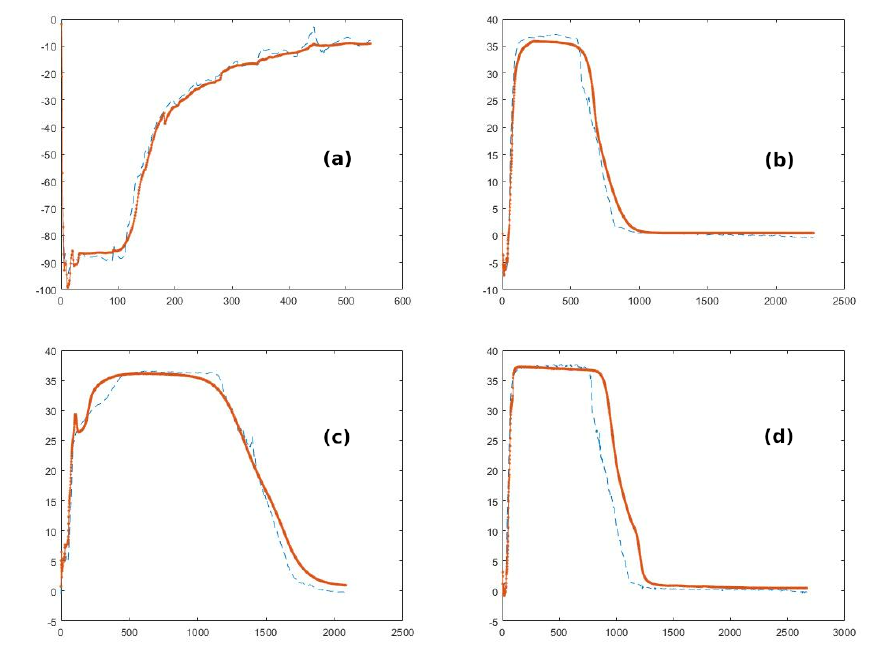
Figure 5. Outcome of the prediction with the neural network of parameters (200, 1300, 400)—(number of data on the x -axis, ∆ T on the y -axis)—( a ) is dehydration, ( b – d ) are hydration.